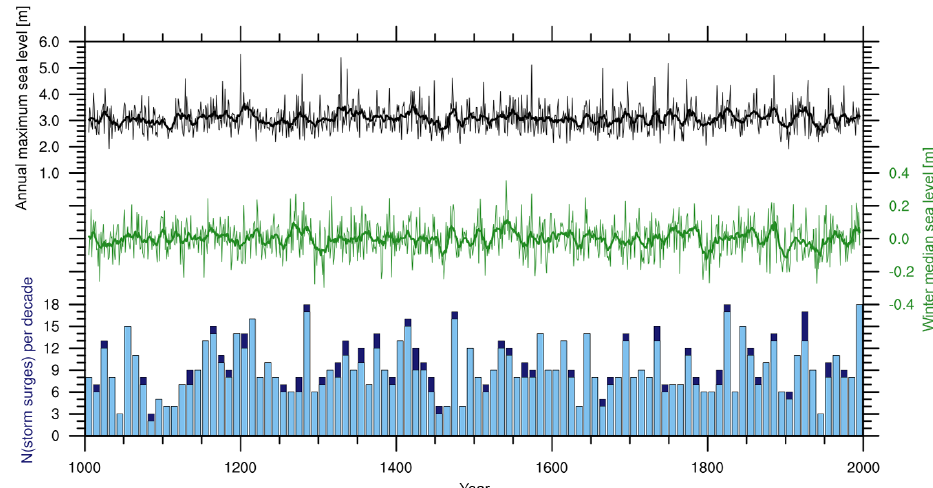
Figure 3. Simulated ESL (black), winter median sea level (green) and number of heavy (blue bars) and extreme (dark blue bars) storm surges per decade at Cuxhaven. Thick lines denote the 11-year running mean.